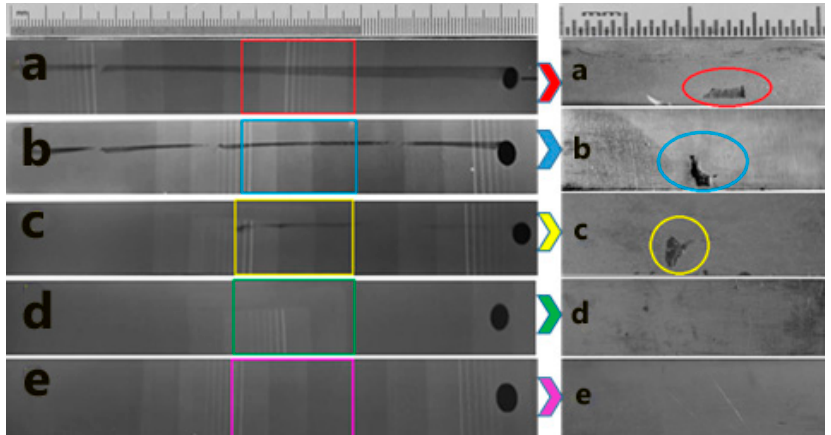
Figure 11. Radiography scan with corresponding section using macro-scan: ( a ): 600 rpm with a welding rate of 16 mm/min, ( b ) 1500 rpm with a welding rate of 52 mm/min, ( c ) 1800 rpm with a welding rate of 32 mm/min, ( d ) 1200 rpm with a welding rate of 32 mm/min, and ( e ) 1000 rpm with a welding rate of 110 mm/min.